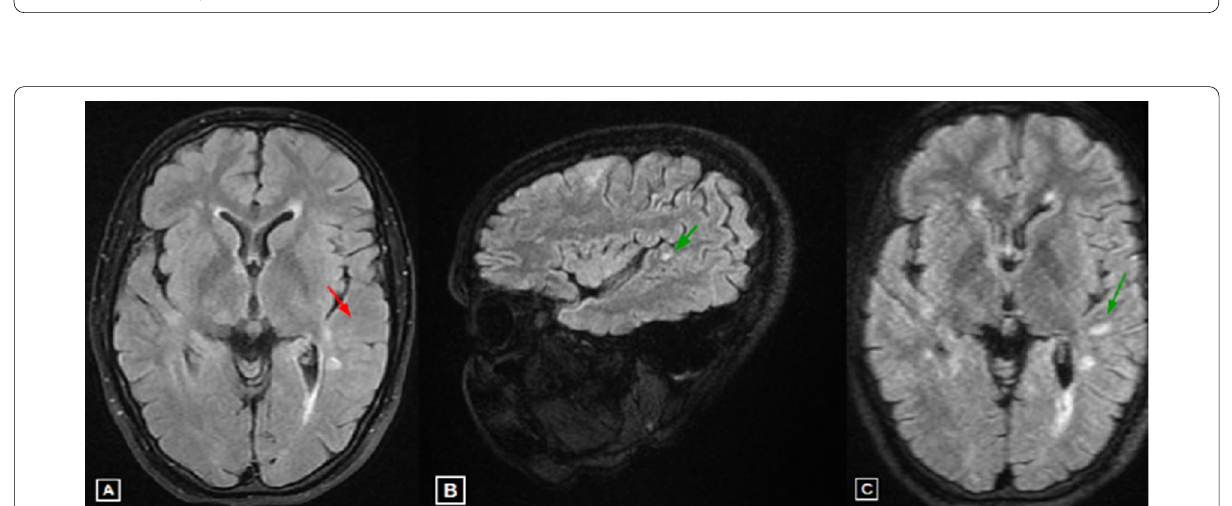
Fig. 2 Supra-tentorial Sections: A well-defined left juxta-cortical temporal lesion (green arrow at B and C ) is not visible in 2D FLAIR cut (red arrow at A ). Furthermore, the axial MIP demonstrates a better delineation of the periventricular